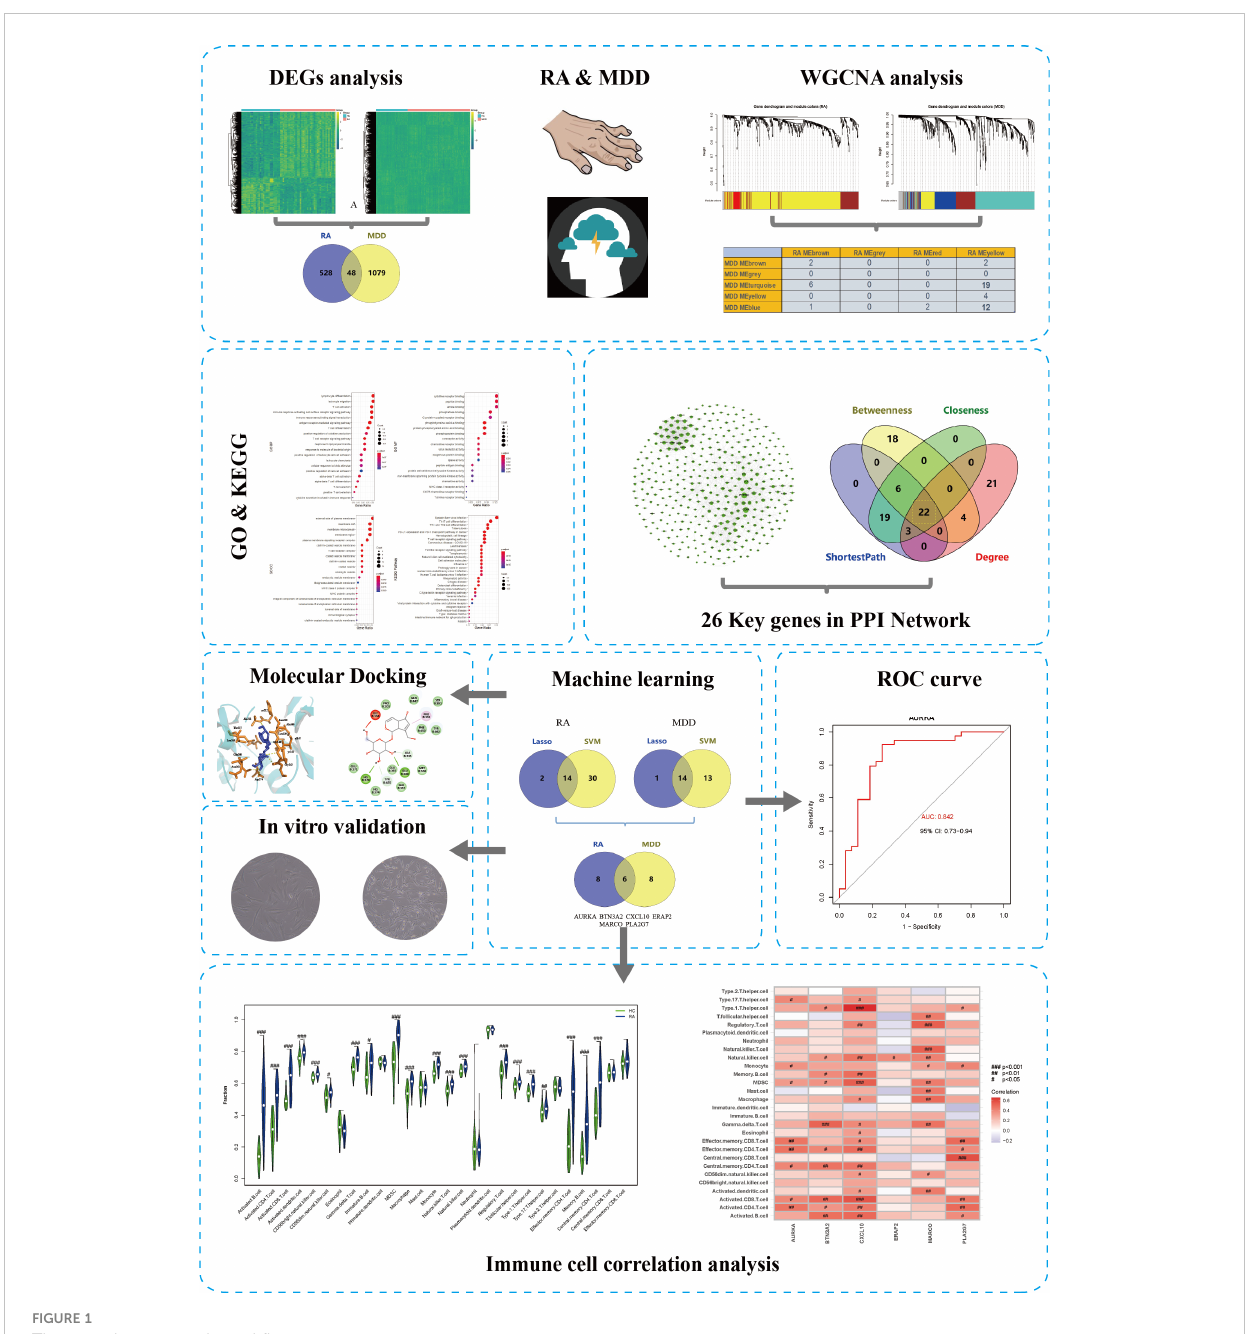
FIGURE 1 The complete research work fl